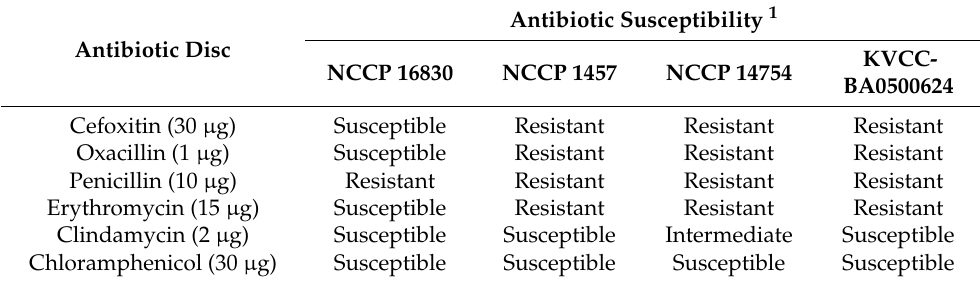
Table 2. Antibiotic resistance profiles of Staphylococcus aureus